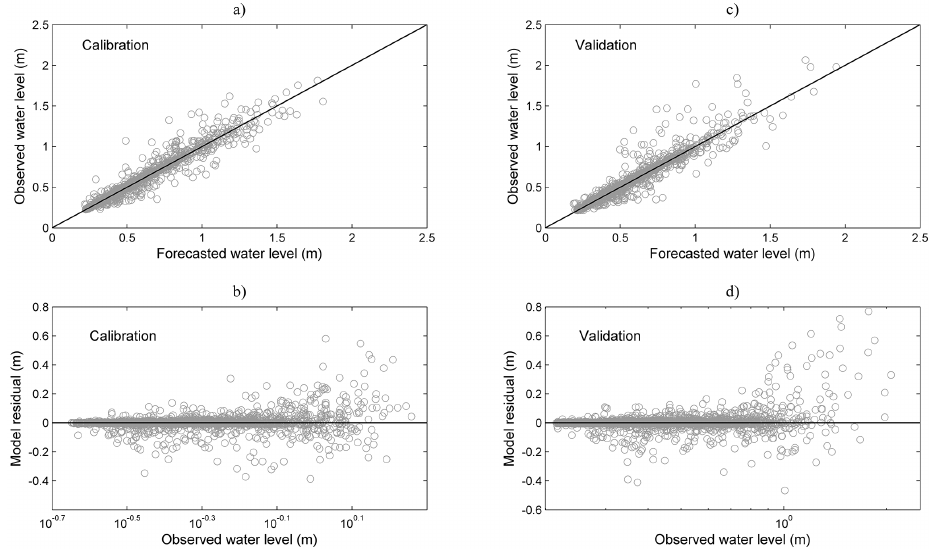
Figure 9. Observed water level, forecasted water level and model residuals during calibration and validation (Llanyblodwel, lead time